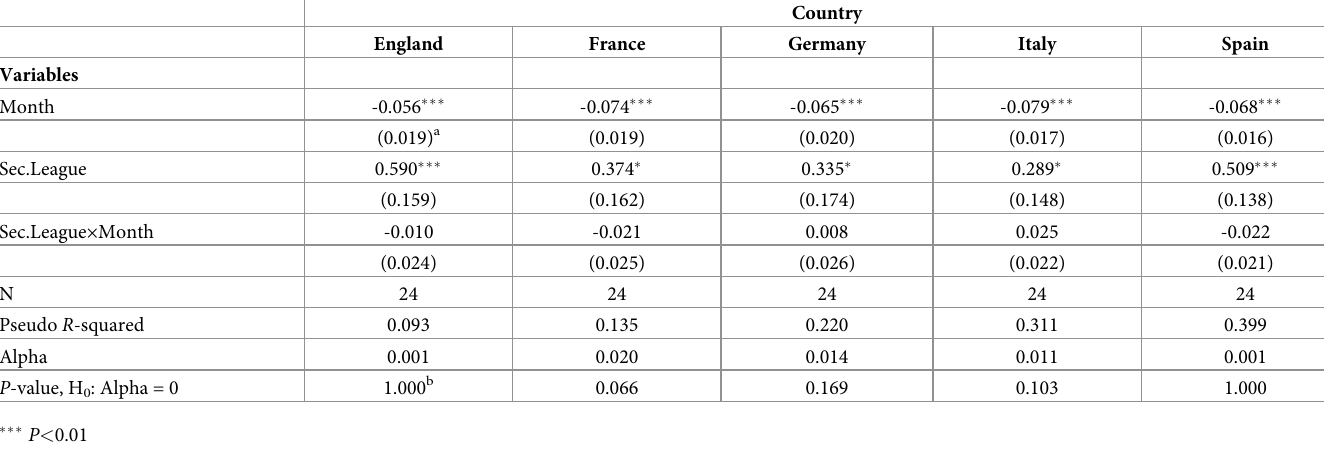
Table 3. RAE on frequency of month of birth in the first- and second-tiers by